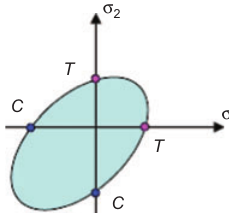
Figure 3 General isotropic failure criterion (adapted from Christensen [5, 6] ). Figure 4 Isotropic failure envelope in σ